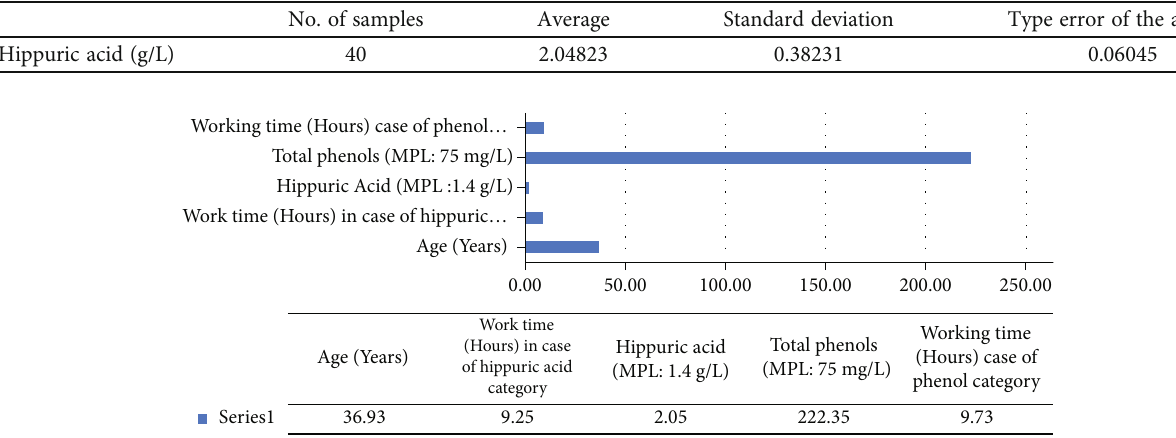
Table 3: One-sample t -test